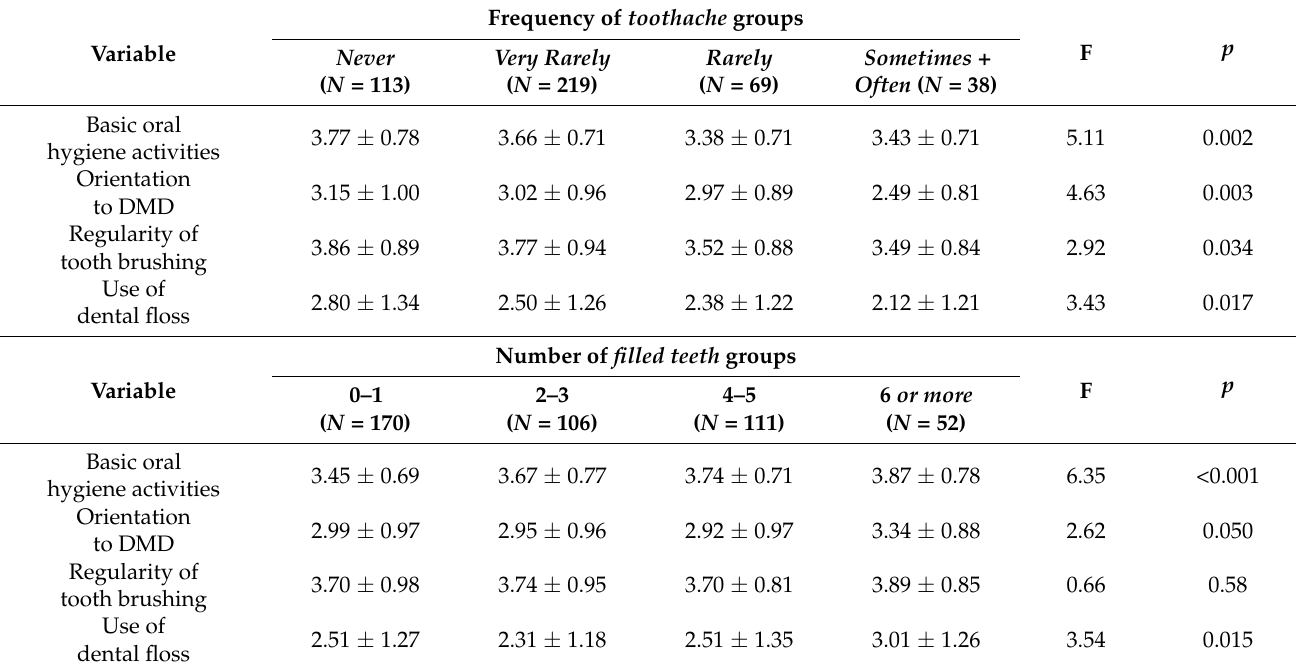
Table 8. Analysis of variance of the OH status groups for female students.